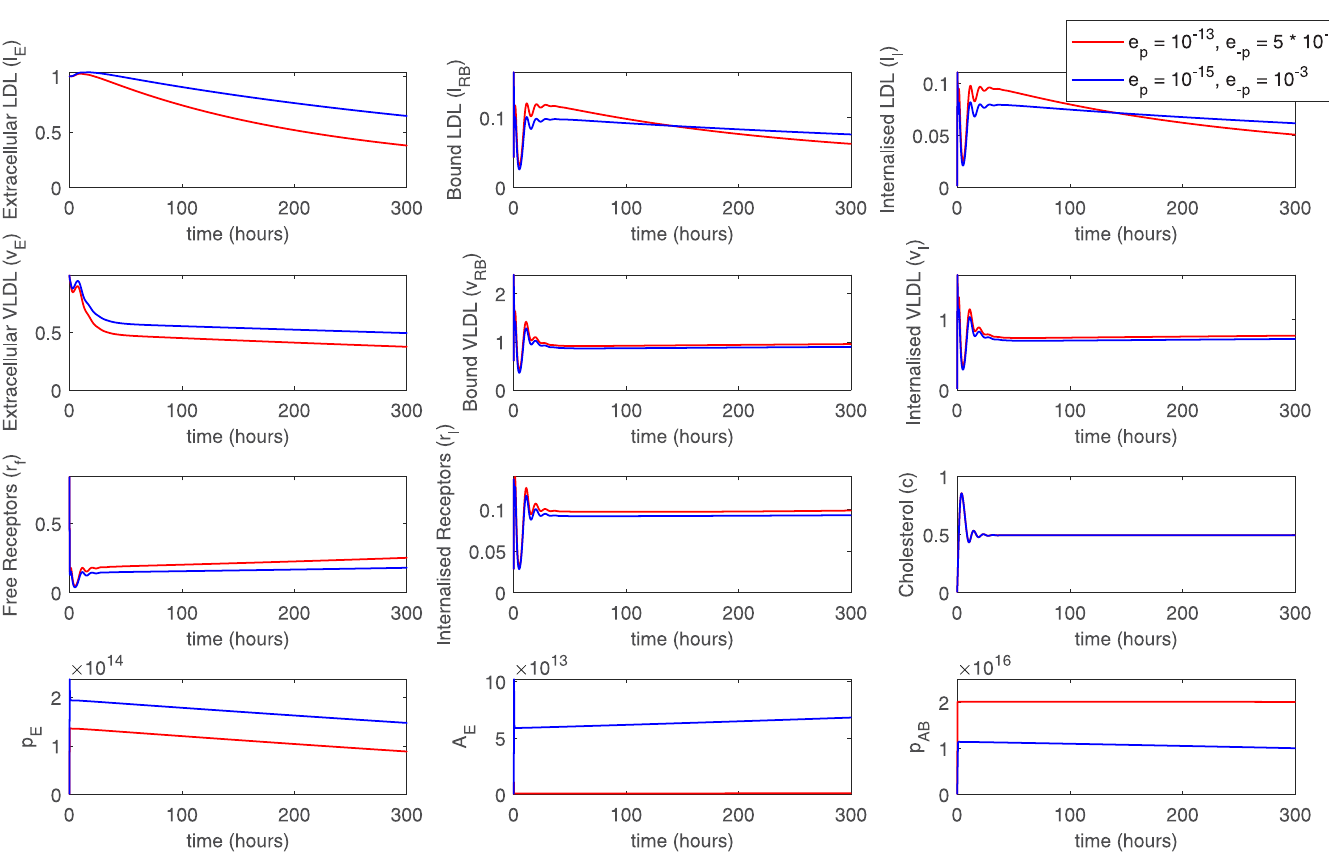
Fig 7. A comparison of therapies with anti-PCSK9 antibodies and small-molecule inhibitors. Due to higher association rate and lower dissociation rate, application of the inhibitory molecules (red curve) at the same concentration as antibodies (blue curve) leads to a faster and stronger decrease in the LDL level.